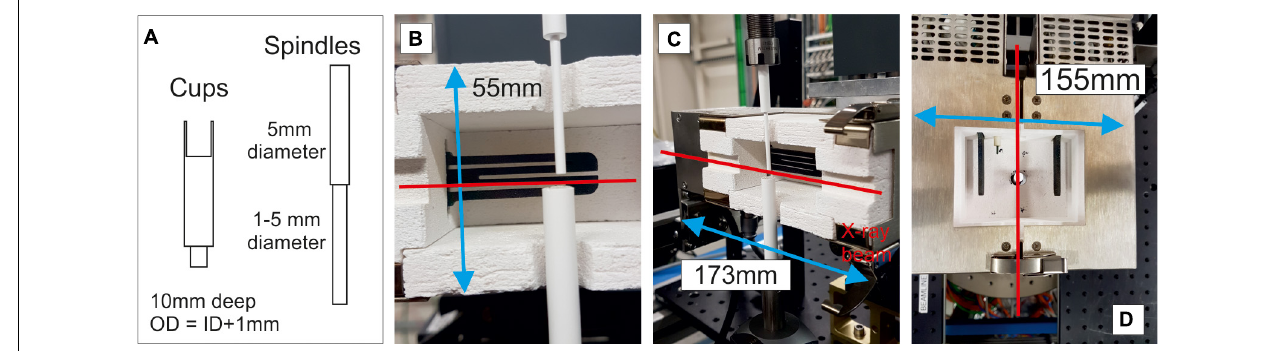
FIGURE 3 | (A) The sample cups and spindles used with the XRheo for high temperature experiments. (B,C) The Pele in situ furnace (see also Figure 1 ) as mounted and used with the XRheo. (D) The Pele in situ furnace with the upper insulation plates removed, this also shows the apertures set to accept the spindles/cups (as shown) could also be used as the X-ray window, mounting the sample from the bottom of this image for high temperature (no deformation) scanning in laboratory scanning